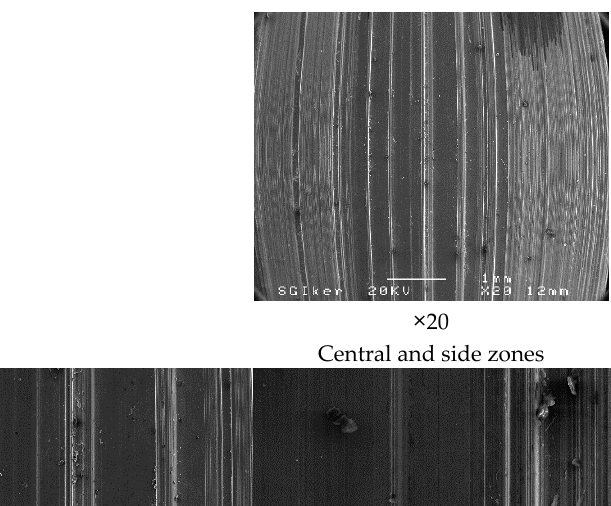
Figure 20. AA ‐ 5754 ‐ N0 disk.